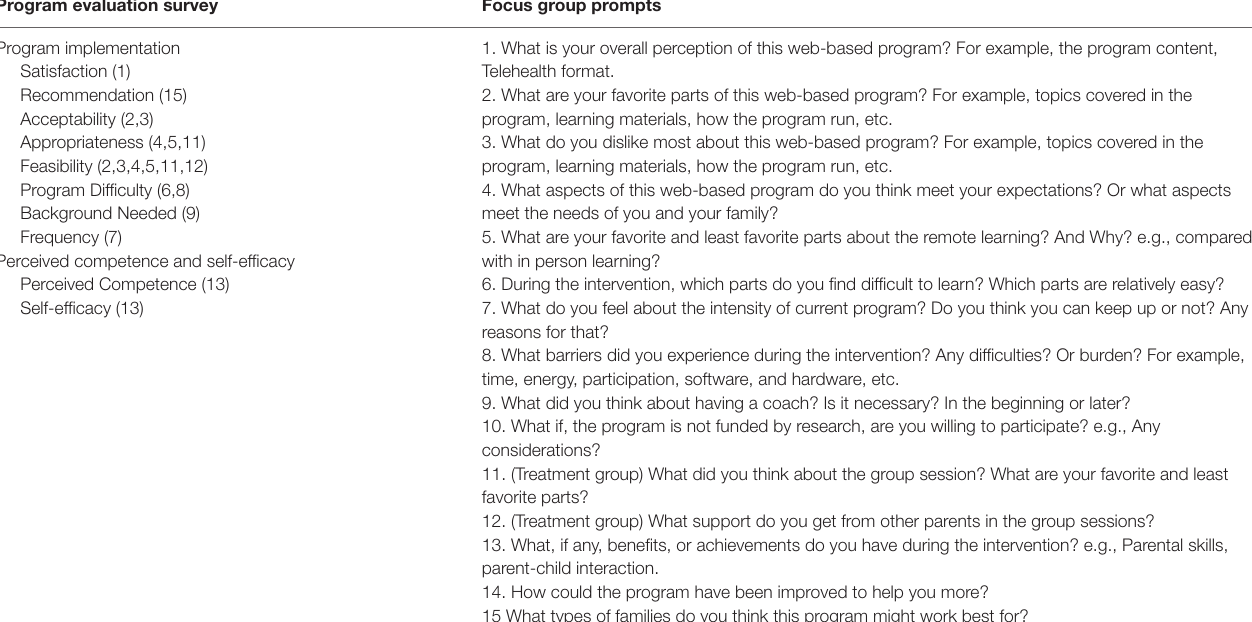
TABLE 3 | Examples of matching survey questions to focus group